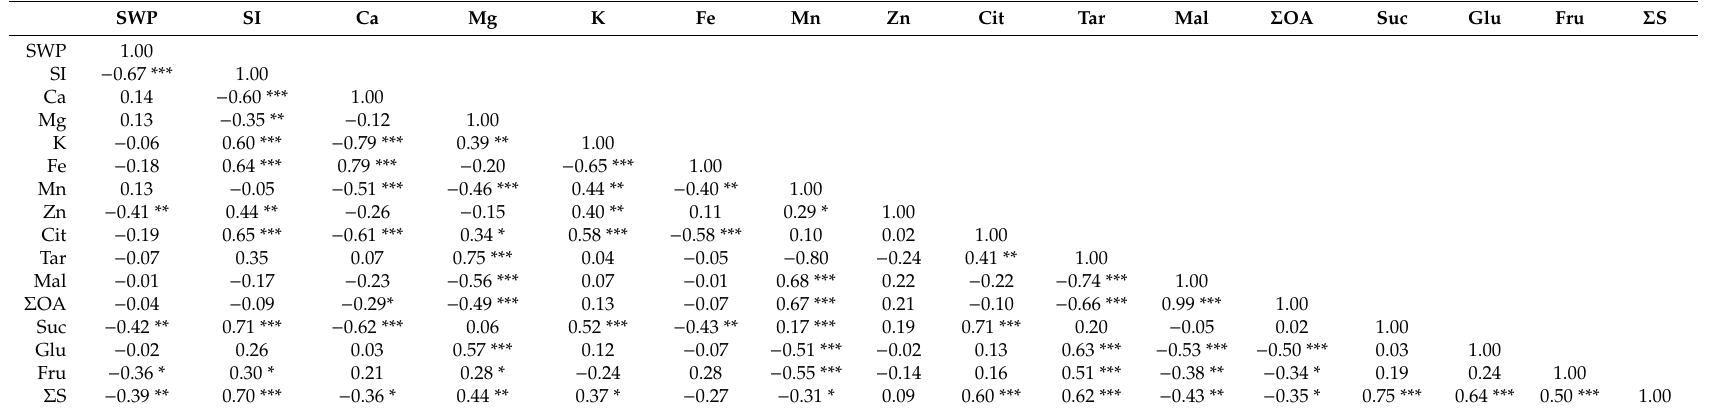
Table 2. Pearson’s correlation coe ffi cients (R) among stem water potential and stress integral with minerals, organic acids, and